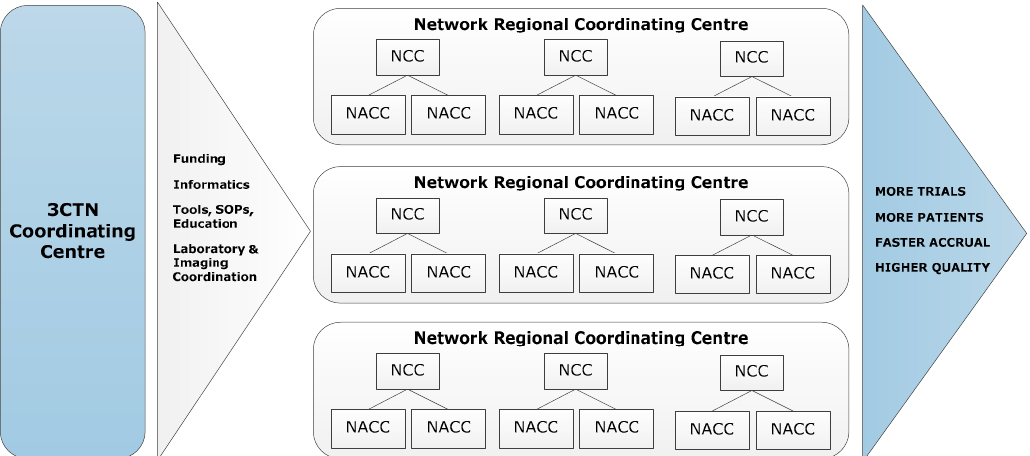
Figure 1. 3CTN organizational framework.